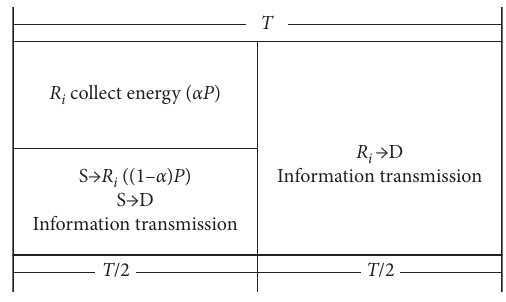
Figure 2: Transmission process of